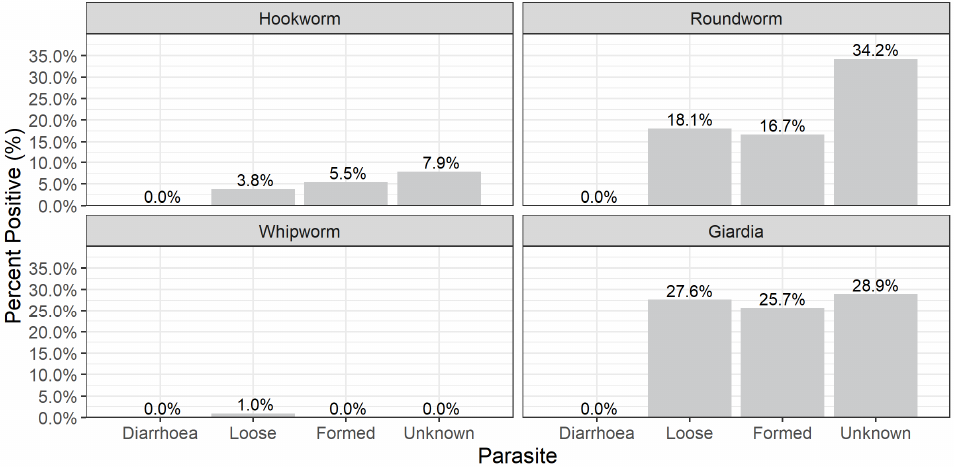
Figure 2. The relationship between faecal consistency and parasites detected in dog samples.